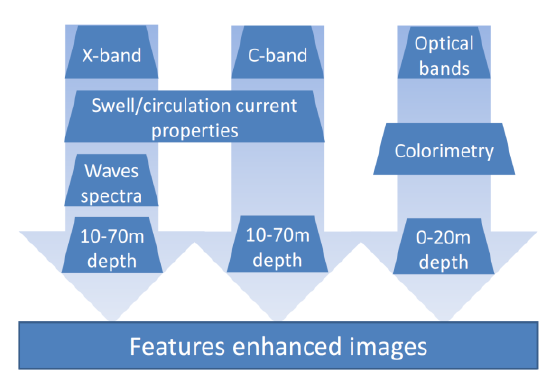
Figure 1. Remote sensing image processing